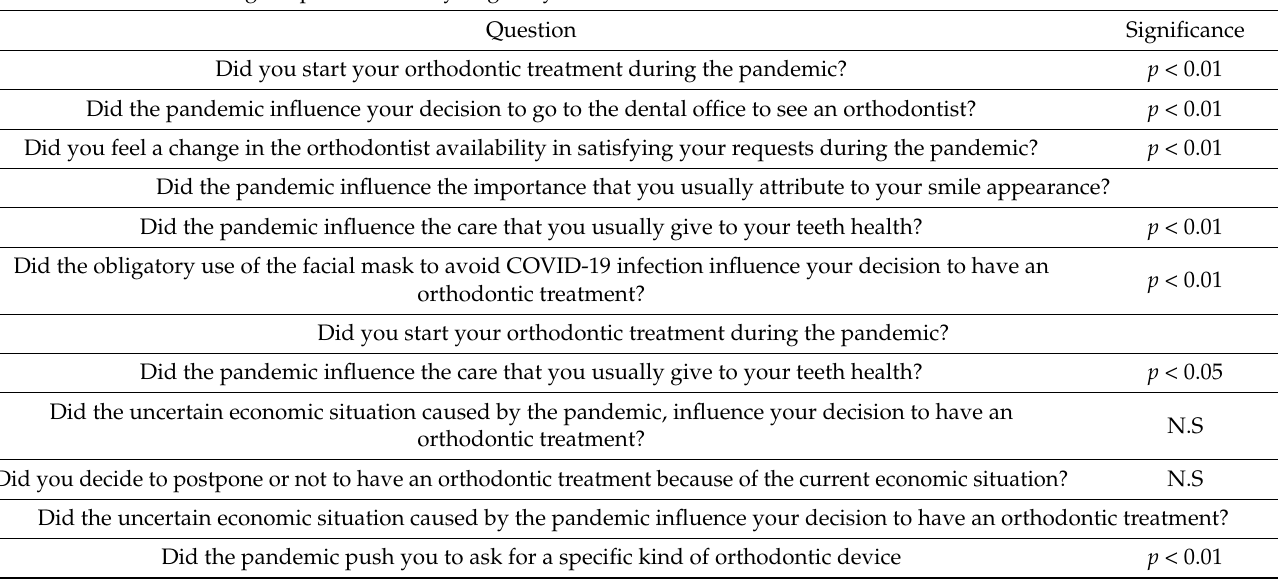
Table 1. Question correlations.